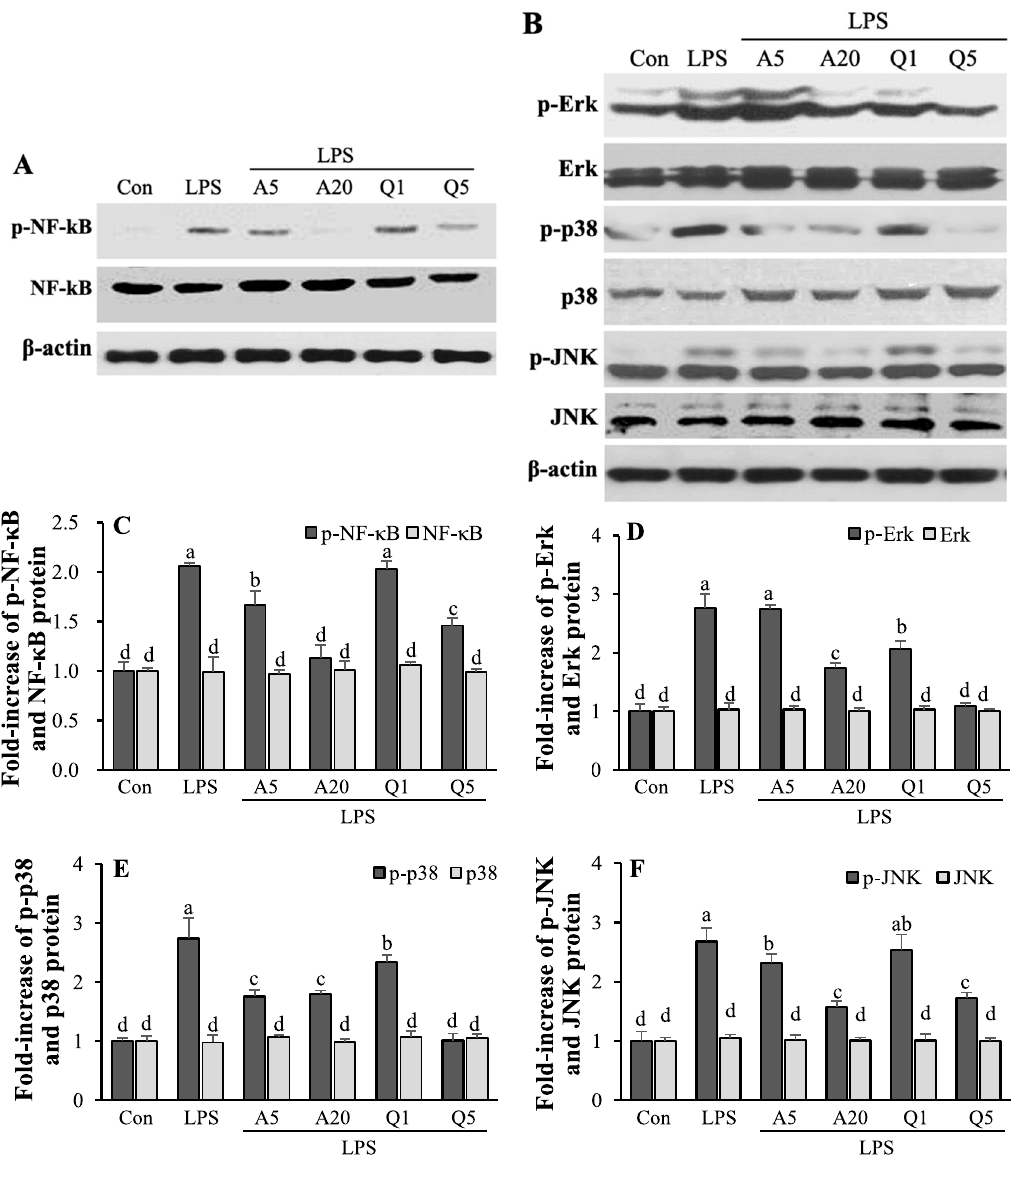
Figure 10. Effects of Ast and Que on the activation of NF-kB, Erk, p38 and JNK in the hippocampus of LPS induced mice ( A – F ). The p-NF- k B, NF- k B, p-Erk, Erk, p-p38, p38, p-JNK, and JNK levels in each sample were normalized to the β -actin level and the density of each protein band was quantified by using SigmaGel software. Con, control: LPS- and sample-untreated cells; Group LPS: cell treated with LPS only. The mRNA levels in each sample were normalized to the data and represent the mean ± SD ( n = 6). The values shown are the mean ± SD ( n = 3) and means labelled with different letters (a–d) within a property differ significantly as determined by Duncan’s multiple range test ( p < 0.05).